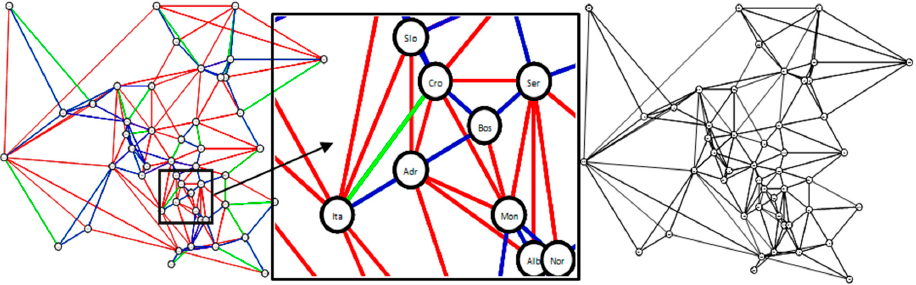
Figure 1. Infrastructure used for the analysis.